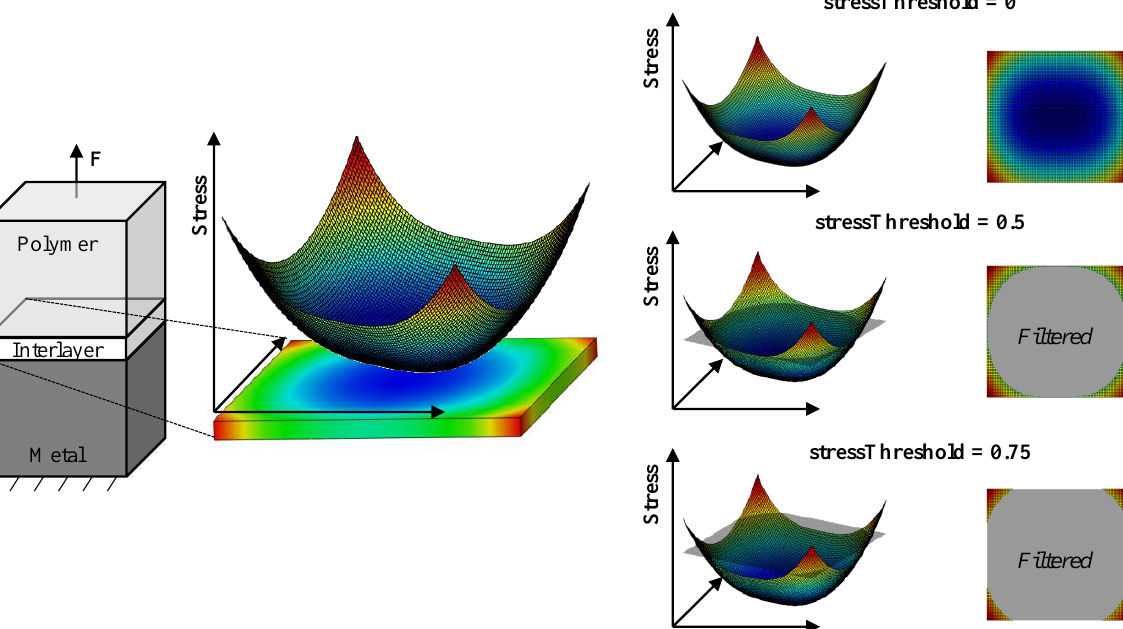
Figure 4. Figure 4. The stress threshold is used to reduce the microstructured area by filtering low-stressed elements.